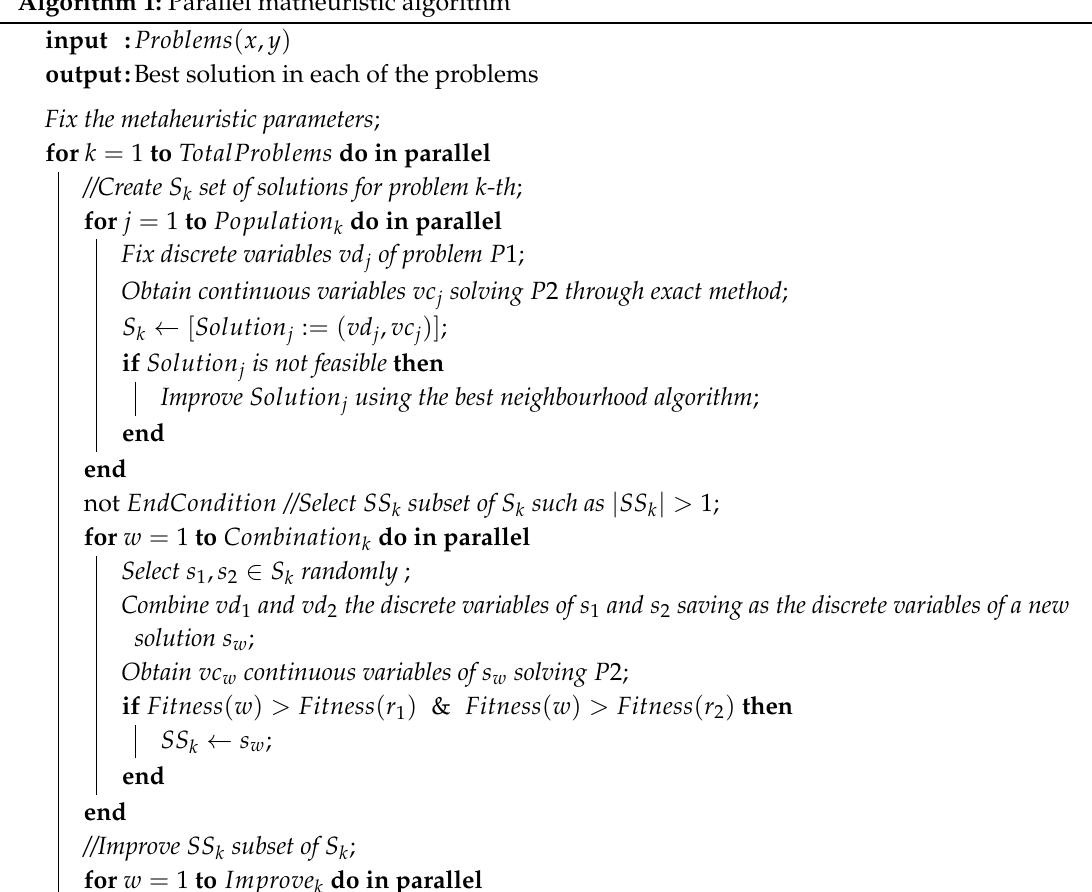
Algorithm 1: Parallel matheuristic